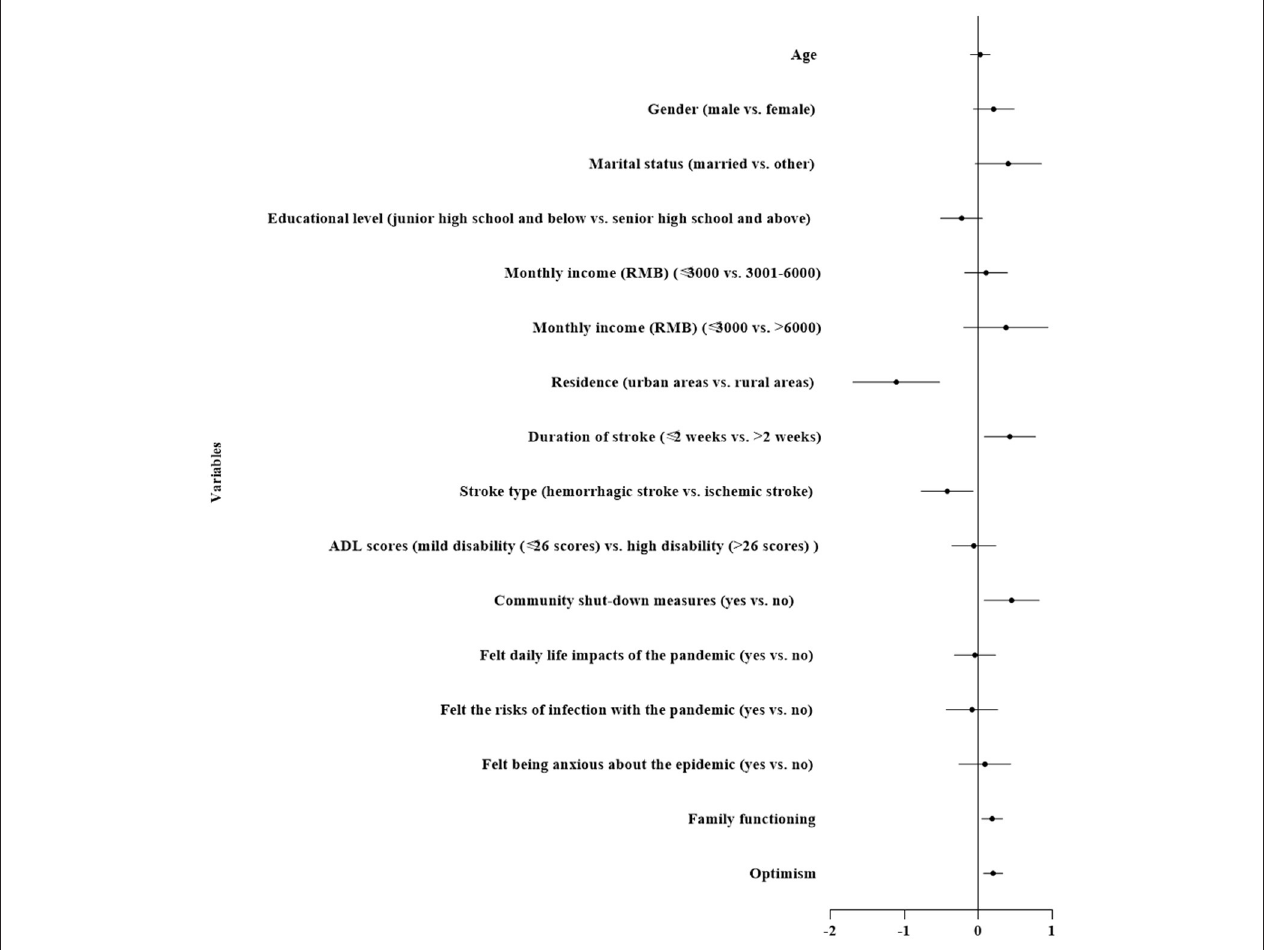
FIGURE 2 | The forest plot of associate factors of life